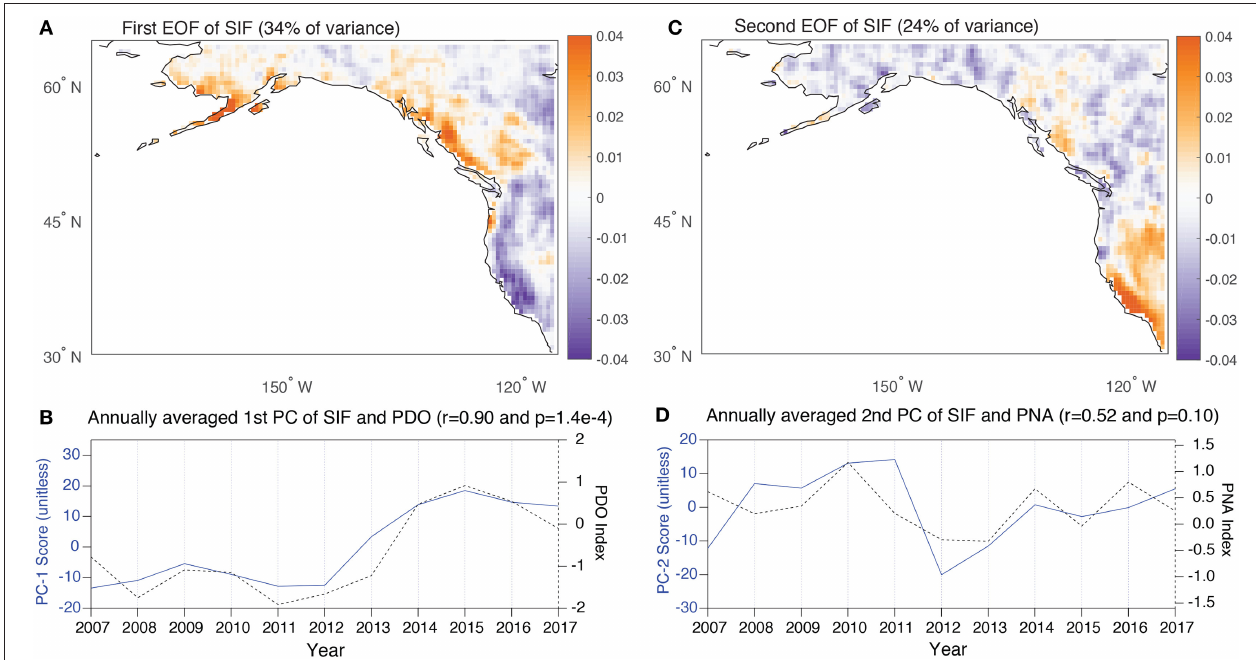
FIGURE 3 | (A,C) The first and second EOF of SIF for the region of interest. The units are dimensionless loadings with explained variances of 34 and 24%, respectively. (B,D) The first and second annually averaged vectors of the PCs associated with the EOFs shown in above panels. The first PC vector is plotted alongside the annually-averaged PDO index ( r = 0.90) and the second PC is plotted alongside PNA ( r = 0.52).